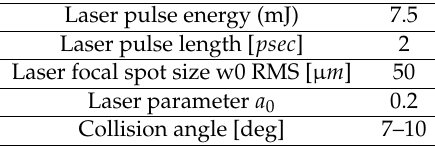
Table 5. Table of laser